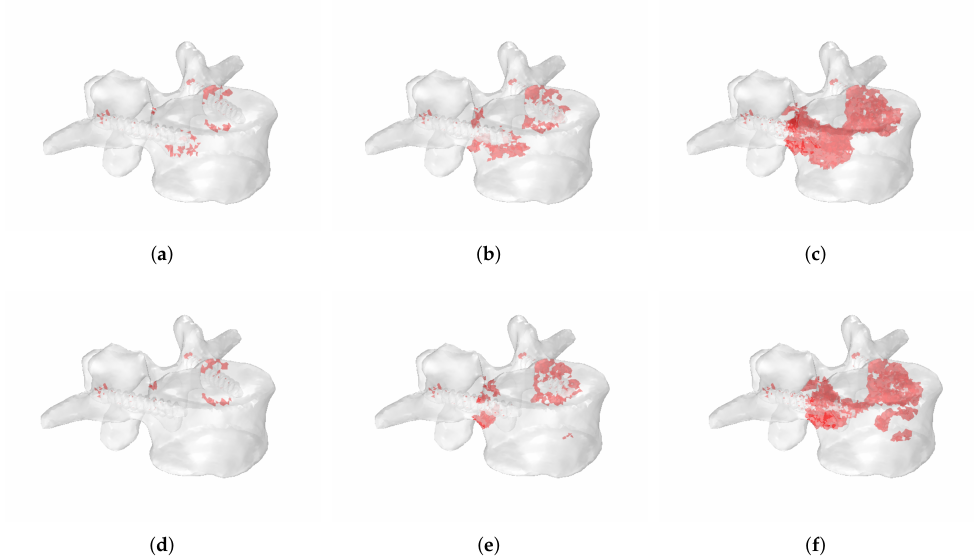
Figure 13. Progression of fracture patterns in an extension-loading condition for an osteoblastic lesion of 10 mm of radius located in P1 ( a – c ) and in P3 ( d – f ) using the stress-based criterion. Failed elements are highlighted in